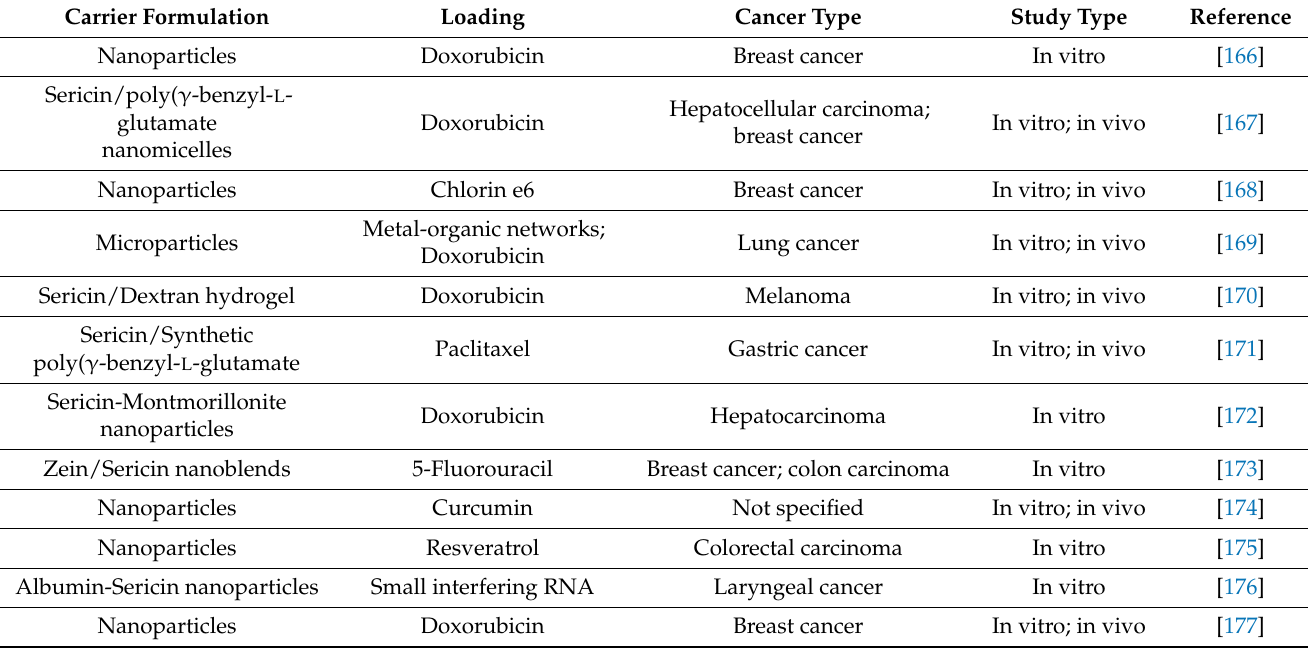
Table 4. Silk sericin carriers for anticancer